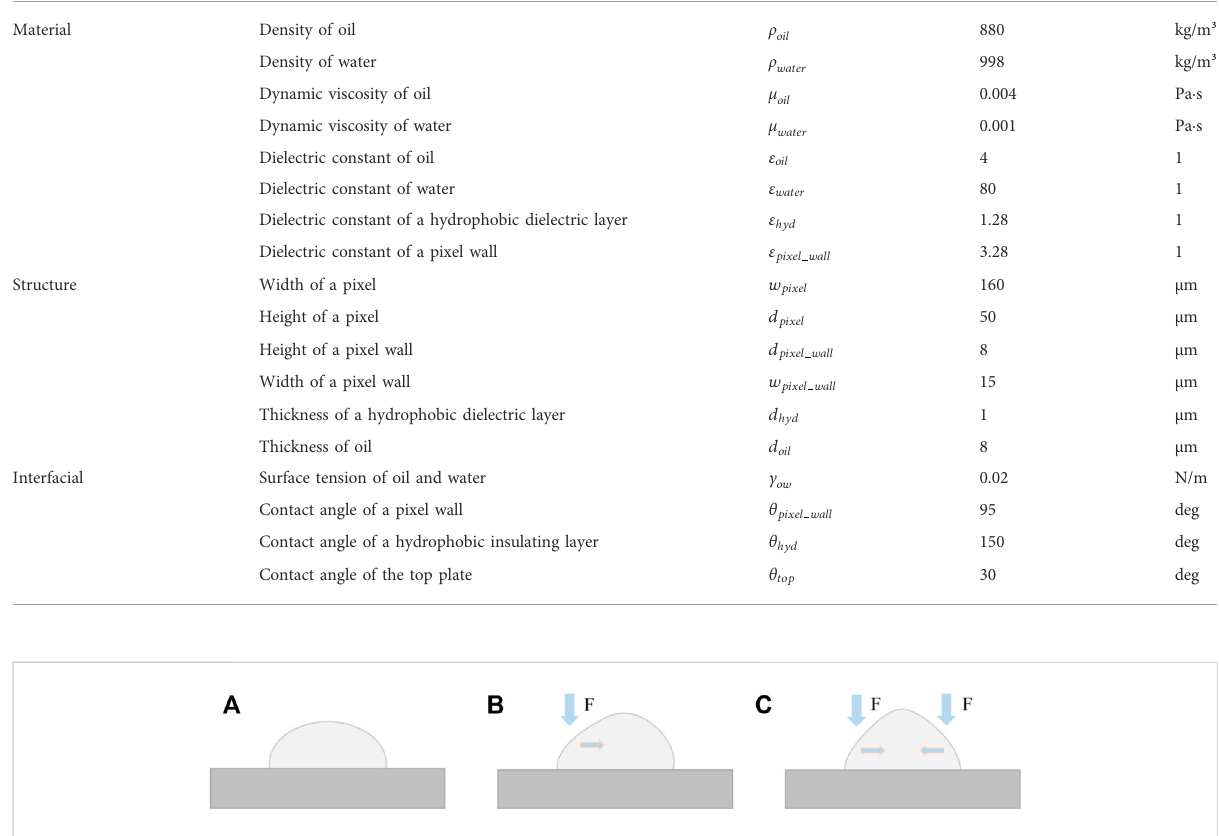
FIGURE 2 Deformation of a sessile droplet exerted by non-contact forces. Vertical arrows indicated the direction of non-contact force, and horizontal arrowsindicatedthedirectionofinternaldropletvelocity. (A) Whenthesessiledropletwasstationary,itwasasemicircularshape. (B) Whenthesessile